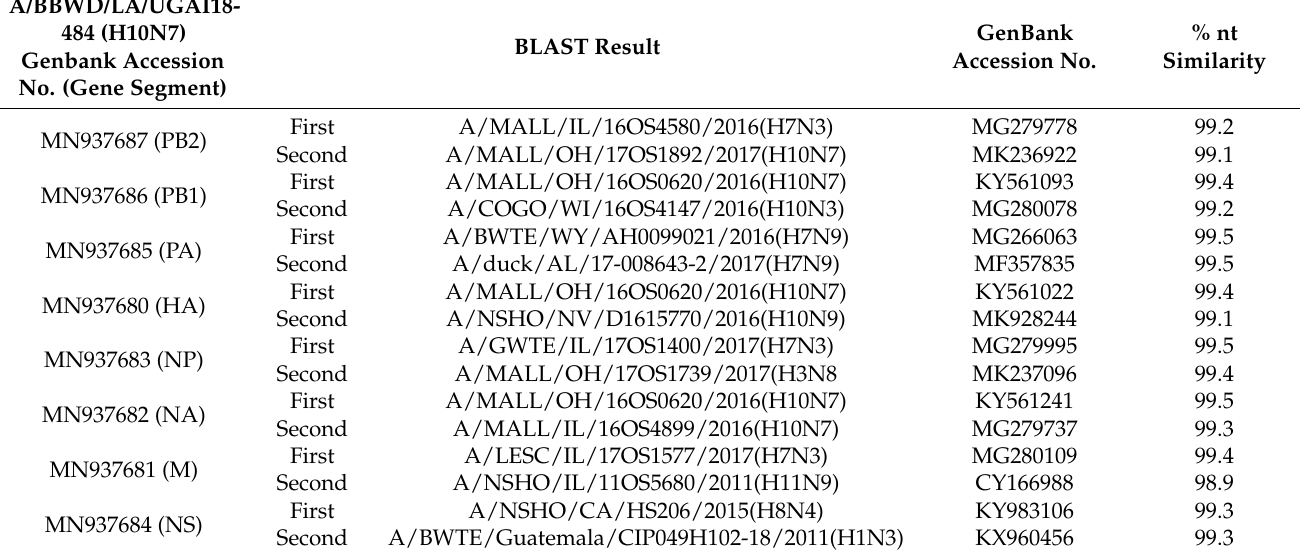
Table 1. Comparison of the eight influenza A virus (IAV) gene sequences for the virus isolated in this study (A/black-bellied whistling duck/Louisiana/UGAI18-484 (H10N7)) with avian IAV available on Genbank that have the highest nucleotide (nt) similarity. Results were obtained on 11 June 2020 using the NCBI basic local alignment search tool (BLAST) function; the top two BLAST results are